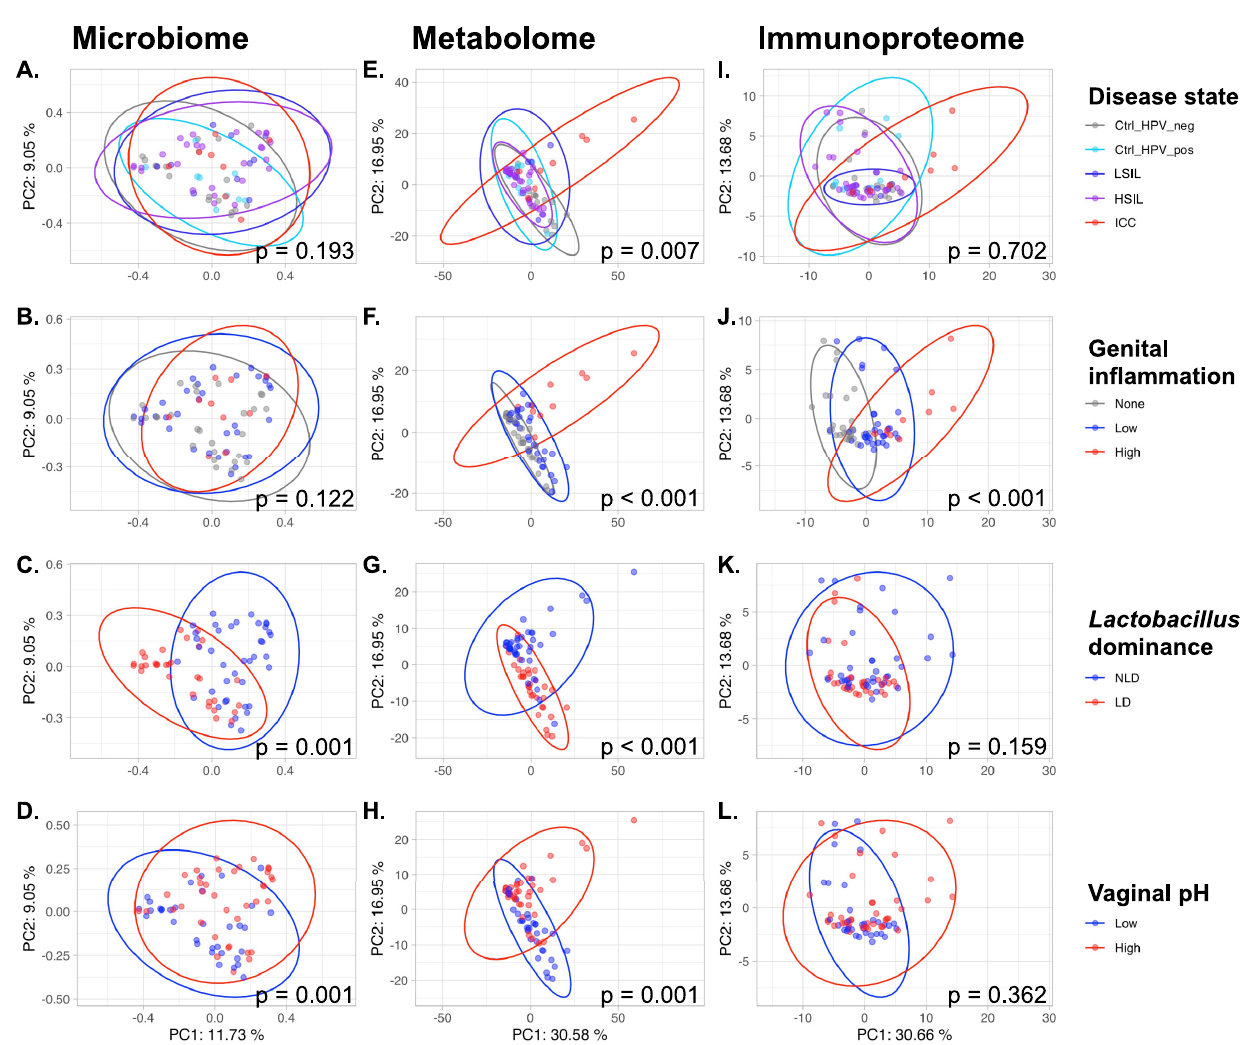
Fig 2. Metabolome features cluster most significantly according to patient covariate groups. A-D. Principal coordinate analysis (PCoA) of the Jaccard distance calculated from microbiome samples. The differences among the groups were tested for significance using a PERMANOVA on the distance matrices. E-L. For metabolome (E-H) and immunoproteome (I-L) features the principal component analysis (PCA) was performed on log-transformed and scaled features (zero mean and unit variance). The differences among groups were assessed using the multivariate analysis of variance (MANOVA) model for the first two principal